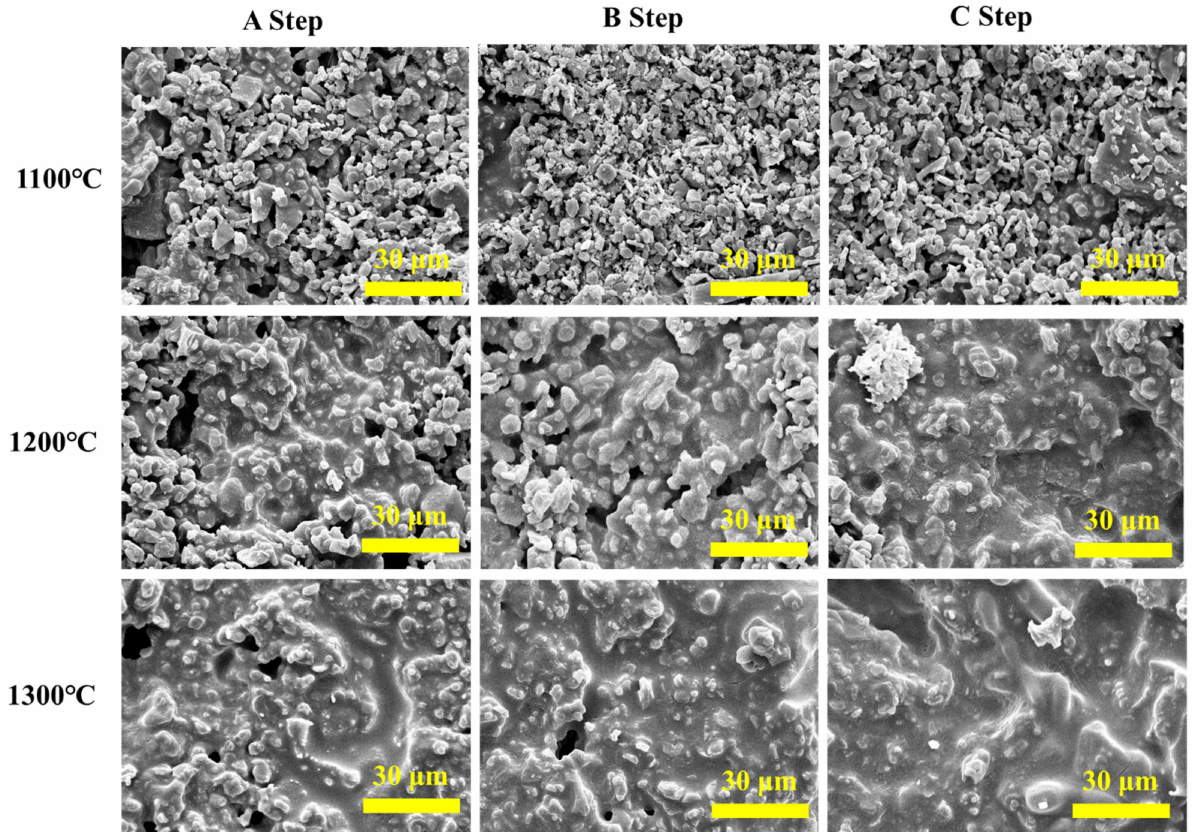
Figure 6. Cross-sectional SEM images of ceramic bodies according to different temperatures with debinding steps A, B, and